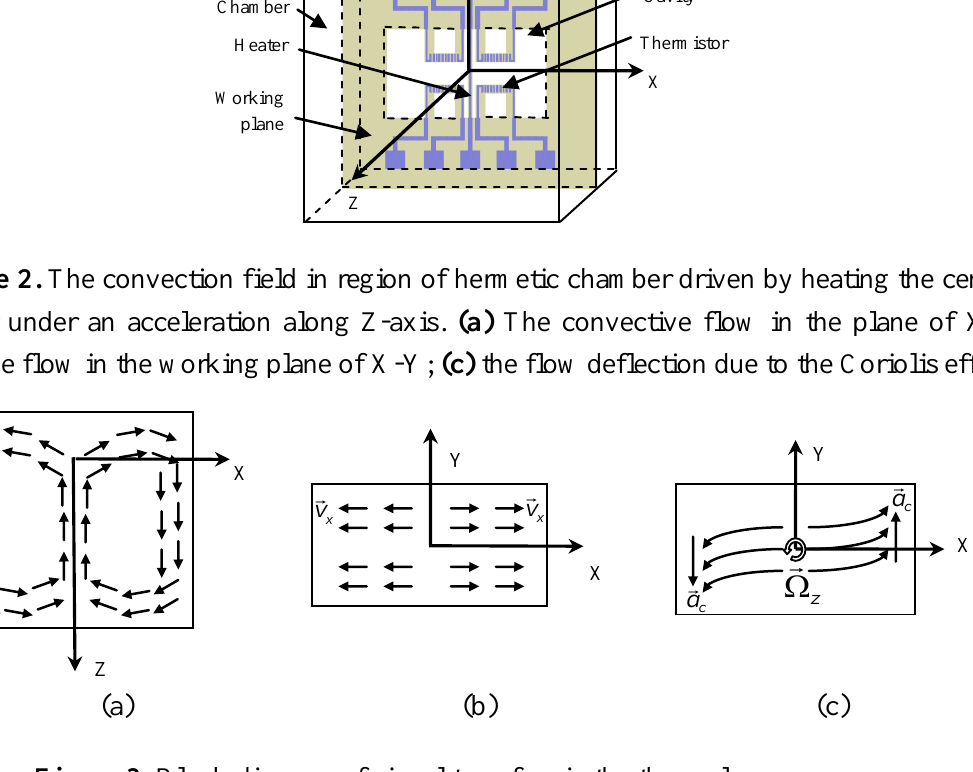
Figure 3. Block diagram of signal transfers in the thermal gas